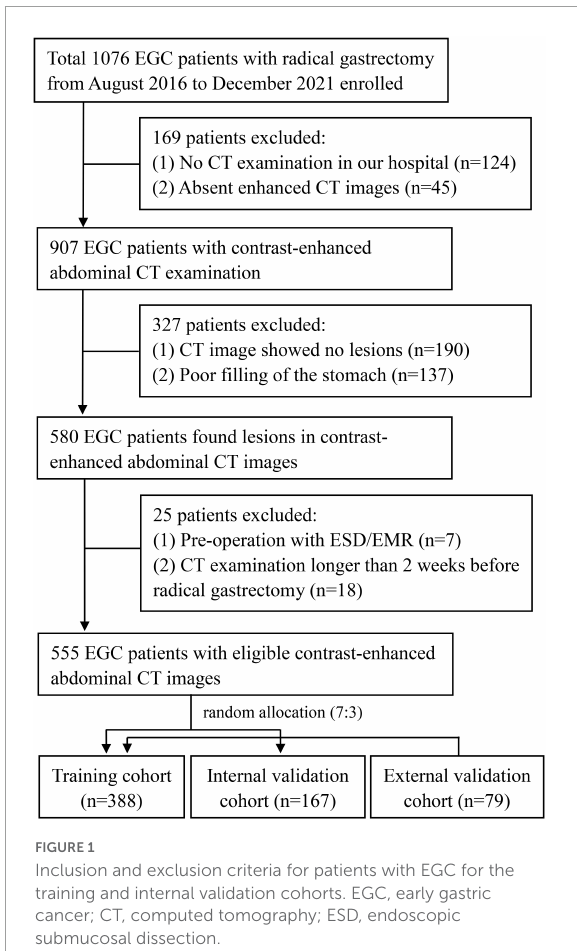
FIGURE1 Inclusion and exclusion criteria for patients with EGC for the training and internal validation cohorts. EGC, early gastric cancer; CT, computed tomography; ESD, endoscopic submucosal